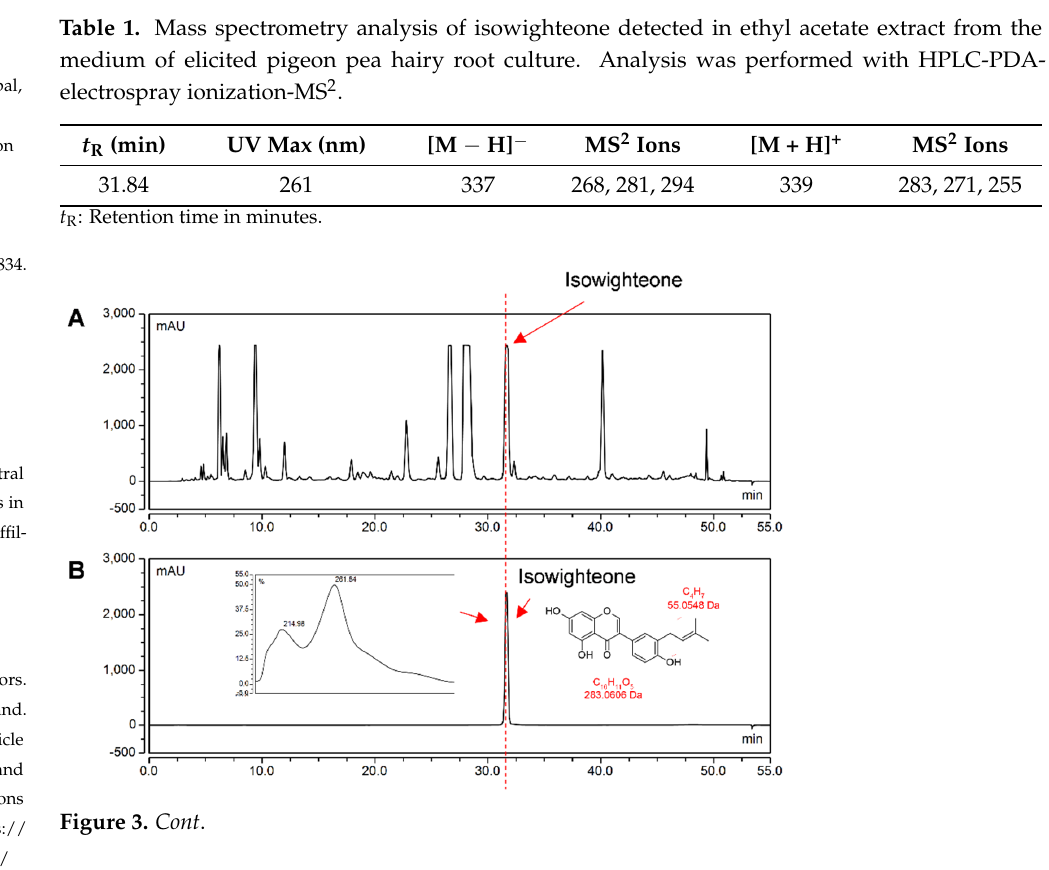
Figure 3. Purification of isowighteone. ( A ) HPLC chromatogram of ethyl acetate extract from the medium of pigeon pea hairy root culture. ( B ) HPLC chromatogram of purified isowighteone with its UV spectrum and chemical structure. All chromatograms were monitored at 260 nm. ( C ) HPLC ‐ PDA ‐ electrospray ionization ‐ MS 2 analysis of isowighteone (left: MS; right: MS 2 ).